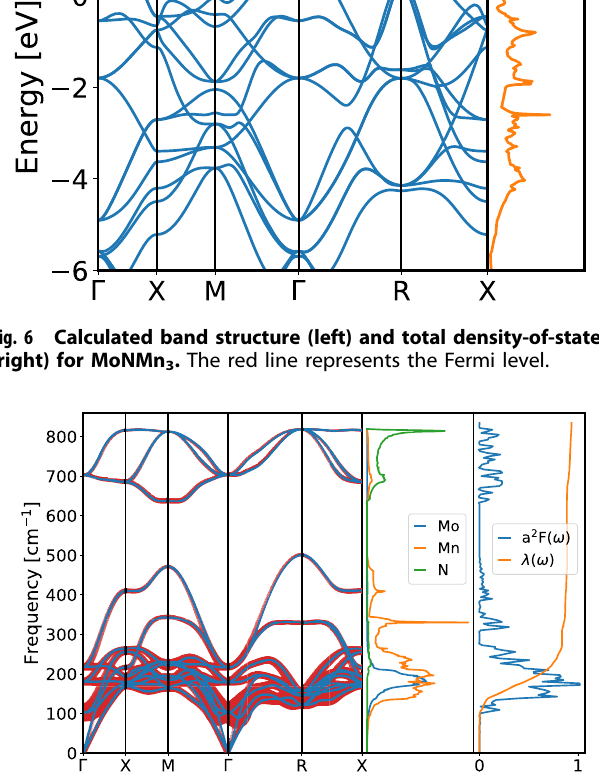
Fig. 7 Calculated phonon dispersion curves (left), projected phonon density-of-states (center), α 2 F ( ω ) and λ ( ω ) (right) for MoNMn 3 . The red circles represent the phonon linewidths with radius proportional to the respective electron – phonon coupling